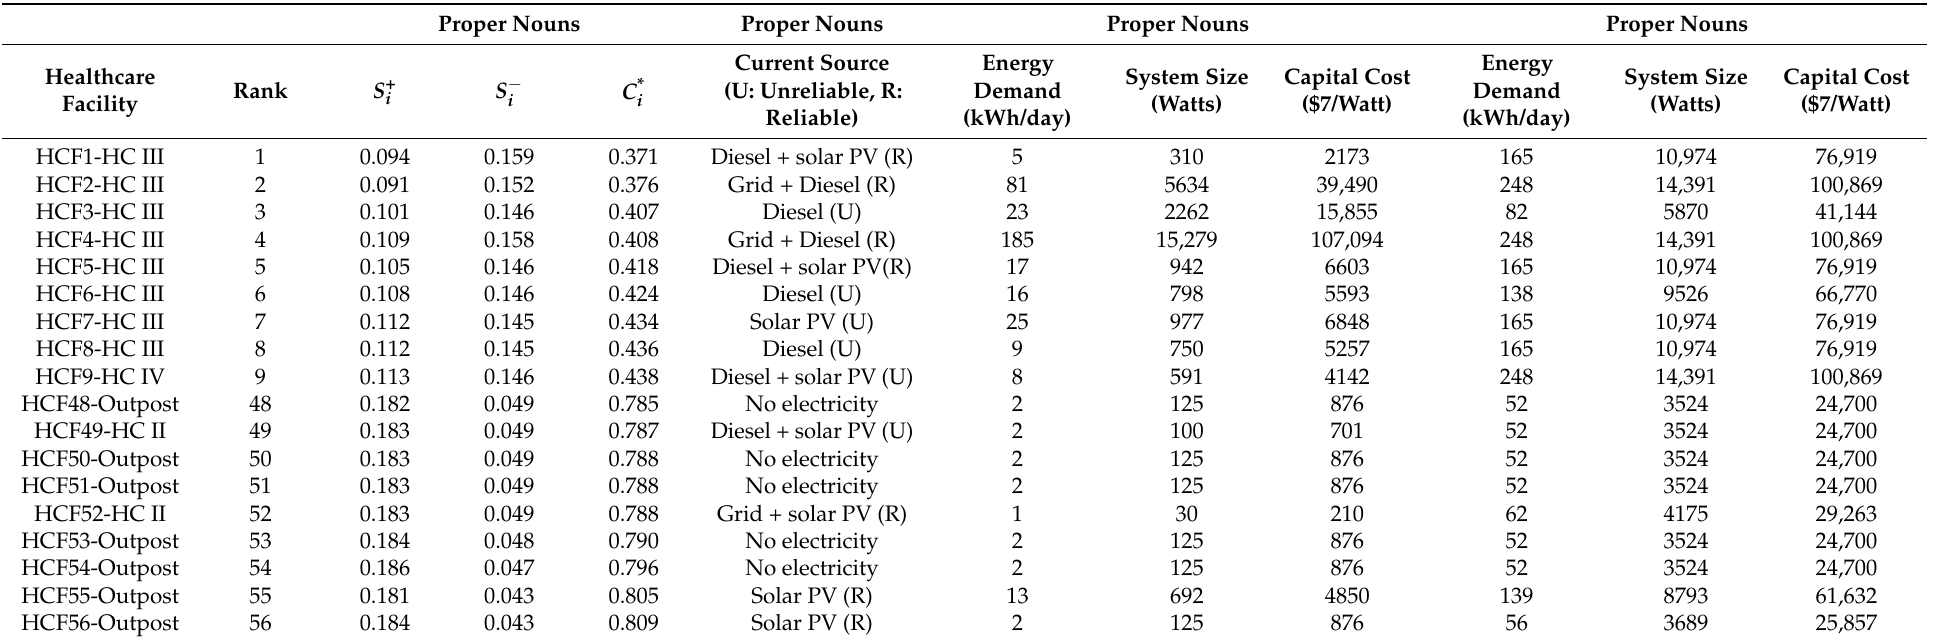
Table 3. Results of TOPSIS analysis and portfolio level energy